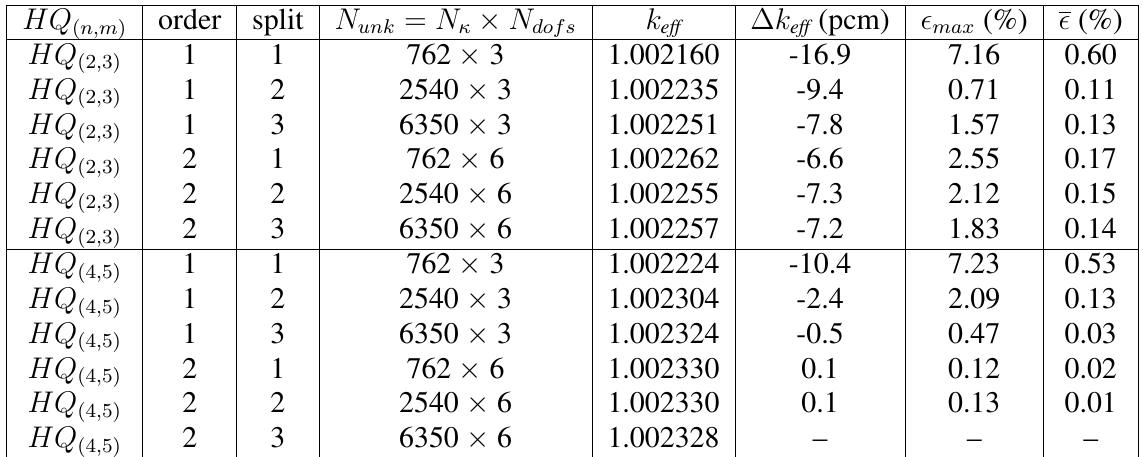
(cid:13) /M INARET